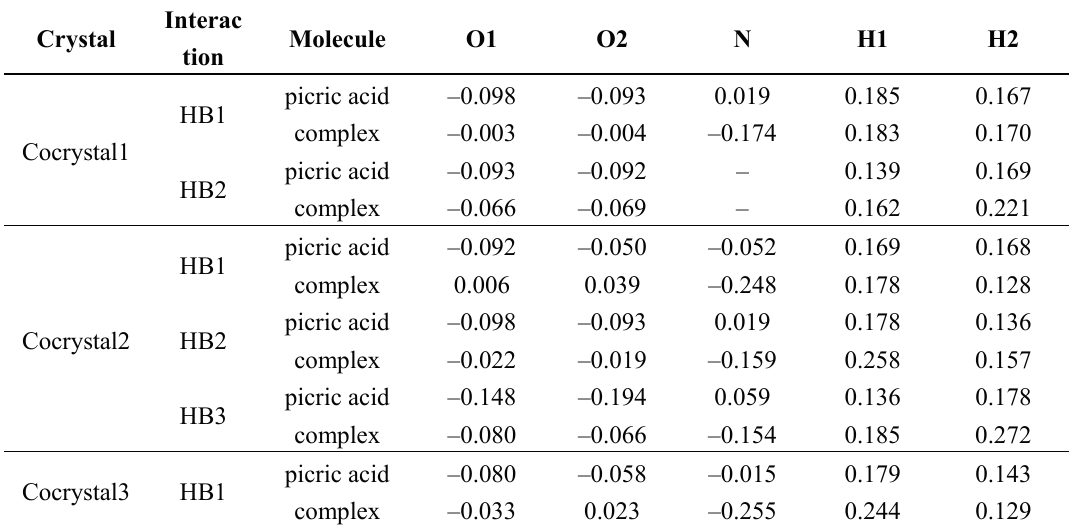
Table 3. The calculated Mulliken charges of picric acid and three